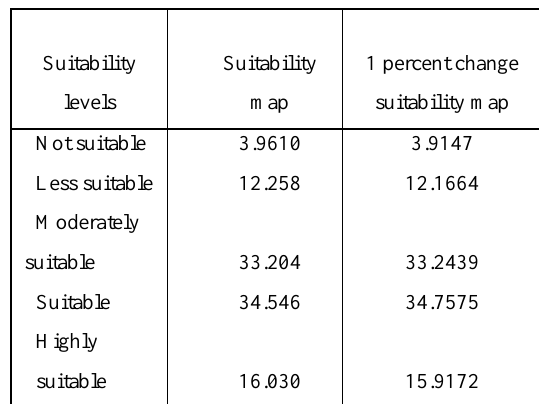
Table 5: Percentage of suitability areas from sensitivity